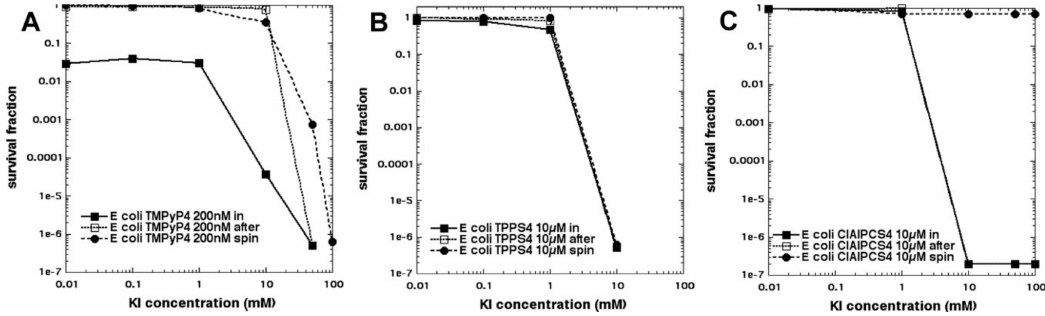
Figure 11. Potentiation of aPDI of E. coli with potassium iodide reveals that TPPS4 behaves like a cationic porphyrin. ( A ) TPMPy4; ( B ) TPPS4; ( C ) ClAlPCS4. Figure adapted from data contained in [30].